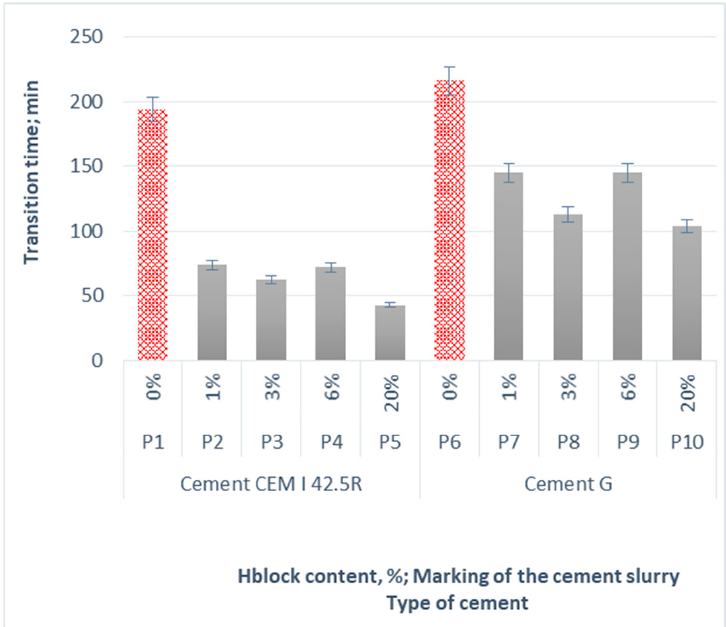
Figure 10. Summary of the values of the transition time from the initial time of the setting to final time of the setting of the tested cement slurries.